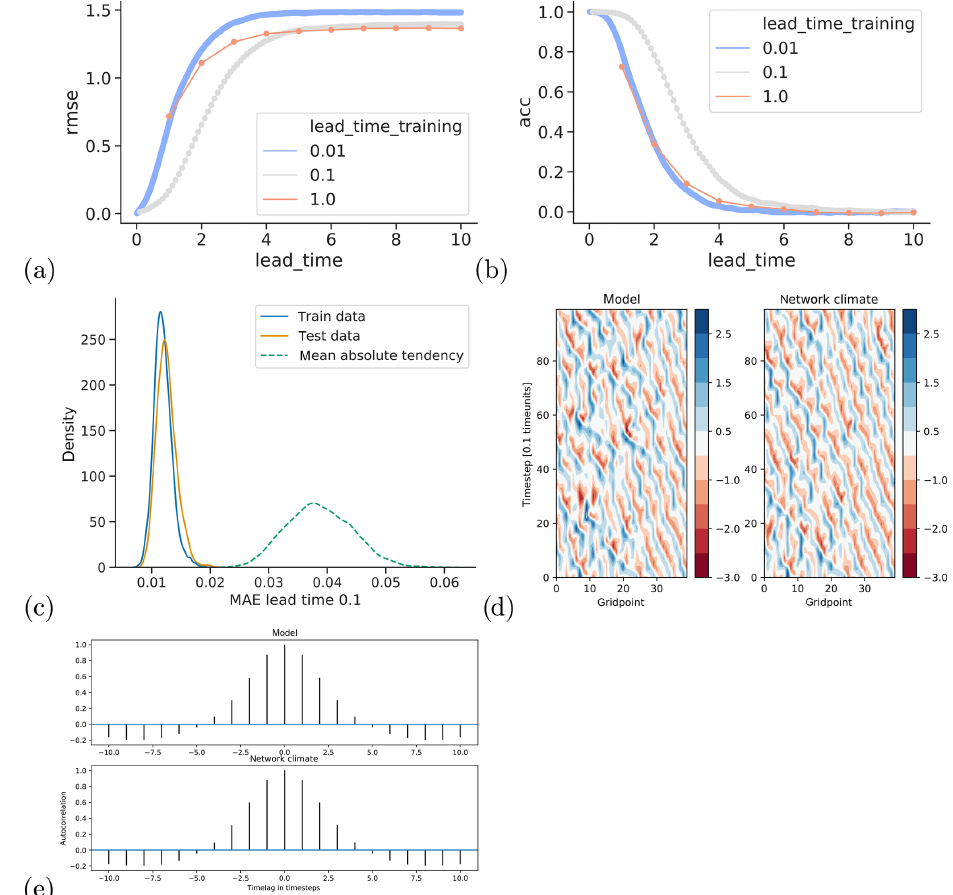
Figure B1. Evaluation of network architecture for the Lorenz95 system without F as input. (a, b) Forecast error (on test data) for the best network configurations when training on lead times of 0.01, 0.1 and 1 (different colors). (c) Kernel density estimate of mean absolute forecast error on training and test data for one-step forecasts of the network trained with a lead time of 0.1 and kernel density estimate of the mean absolute one-step tendencies of the model (dashed line). (d) Examples of the Lorenz95 model (left) and the network model obtained through iterated forecasts trained on a lead time of 0.1 (right), both initialized from the same initial state. (e) Autocorrelation for different time lags of the model and the network